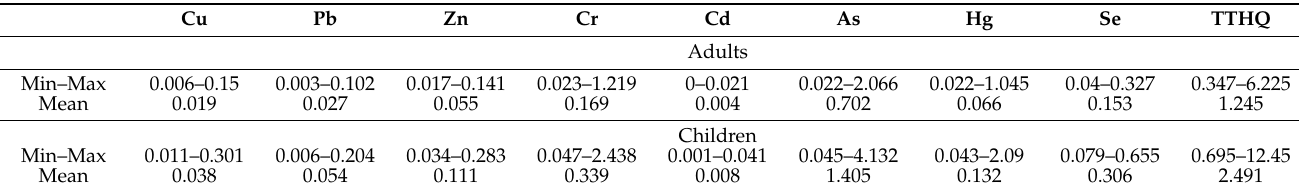
Table 2. The health risk of metals in angling fish of Guangzhou